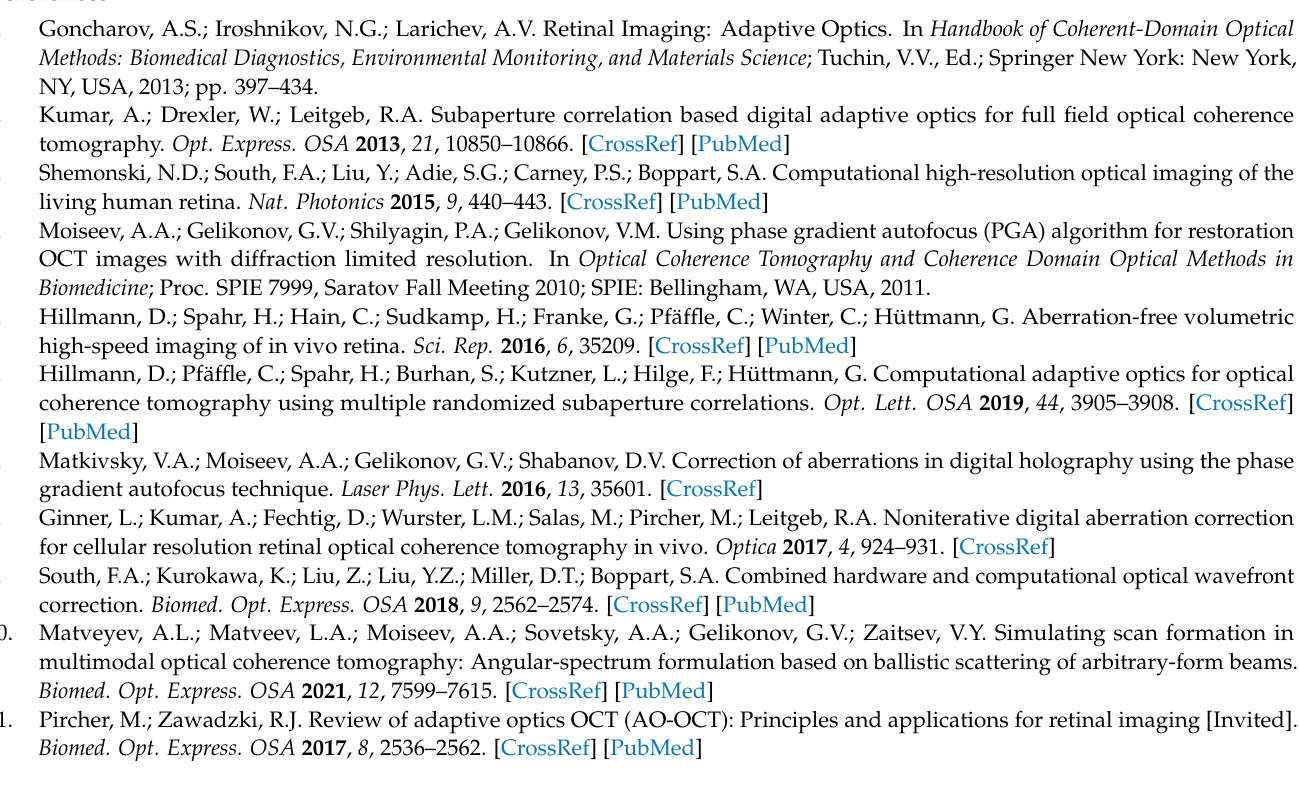
Figure A4. Photo of a binary mask, generated by the DLP matrix.